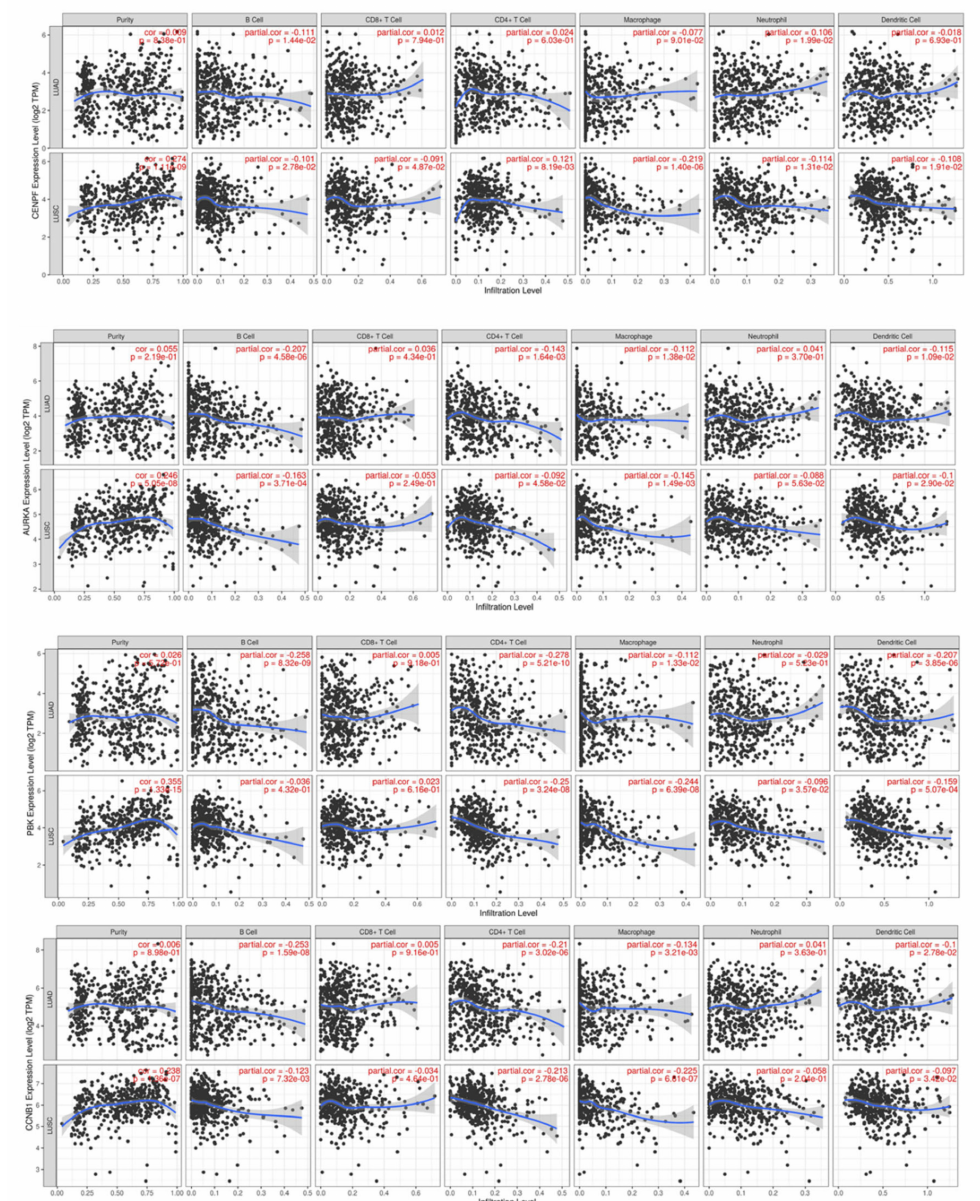
Figure 7. Correlation of hub genes with tumor-infiltrating immune